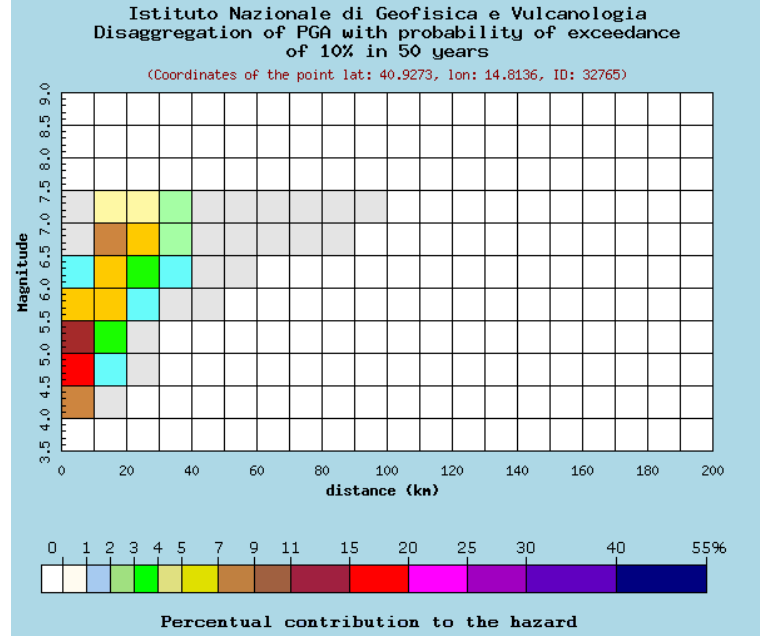
Figure 3. Percentage of contribution to seismic hazard of the 32,765 node which is the nearest to the historical center of Avellino (from http://esse1-gis.mi.ingv.it), as a function of magnitude (M) and historical center of Avellino (from http: // esse1-gis.mi.ingv.it), as a function of magnitude (M) and distance (R). Mean values: M = 5.8; R = 14.0; ε = 1.13. distance (R). Mean values: M = 5.8; R = 14.0; ε =